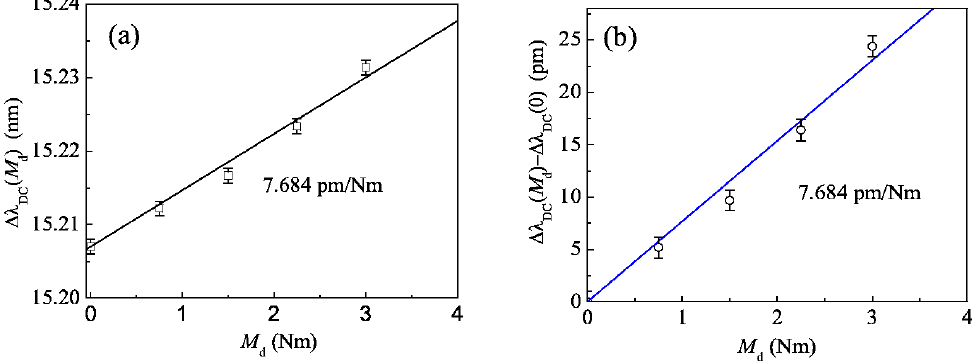
Figure 6. Central wavelength versus driving torque: ( a ) Δλ DC ( M d ); ( b ) Δλ DC ( M d ) − Δλ DC (0).